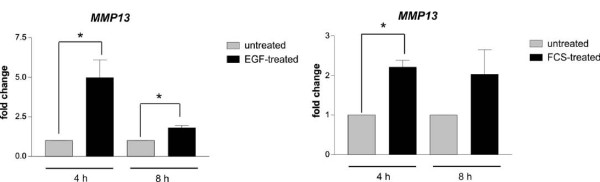
Upregulation of human MMP13 in response to FCS. A375 cells were starved for two days in presence of 0.5% dialyzed FCS and stimulated by the addition of 100 ng/ml EGF or 10% FCS. After 4 and 8 h, cells were harvested and monitored for the expression of MMP13 by realtime PCR. Human ribosomal S14 was used as reference gene. *: p < 0.05 (Student's t test, paired, two-tailed).